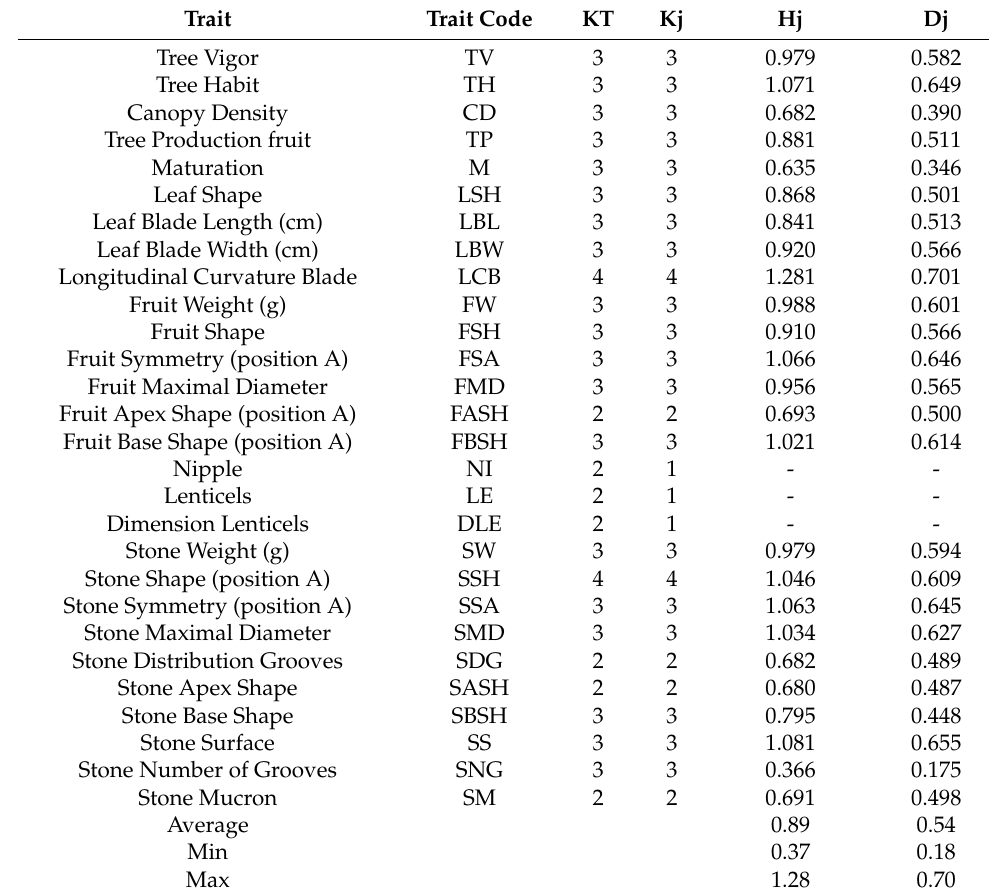
Table 5. Results obtained for diversity indices on qualitative traits analysis: number of total classes (KT), number of observed classes (Kj), Shannon’s information index (Hj) and Discriminating power (Dj) are reported.